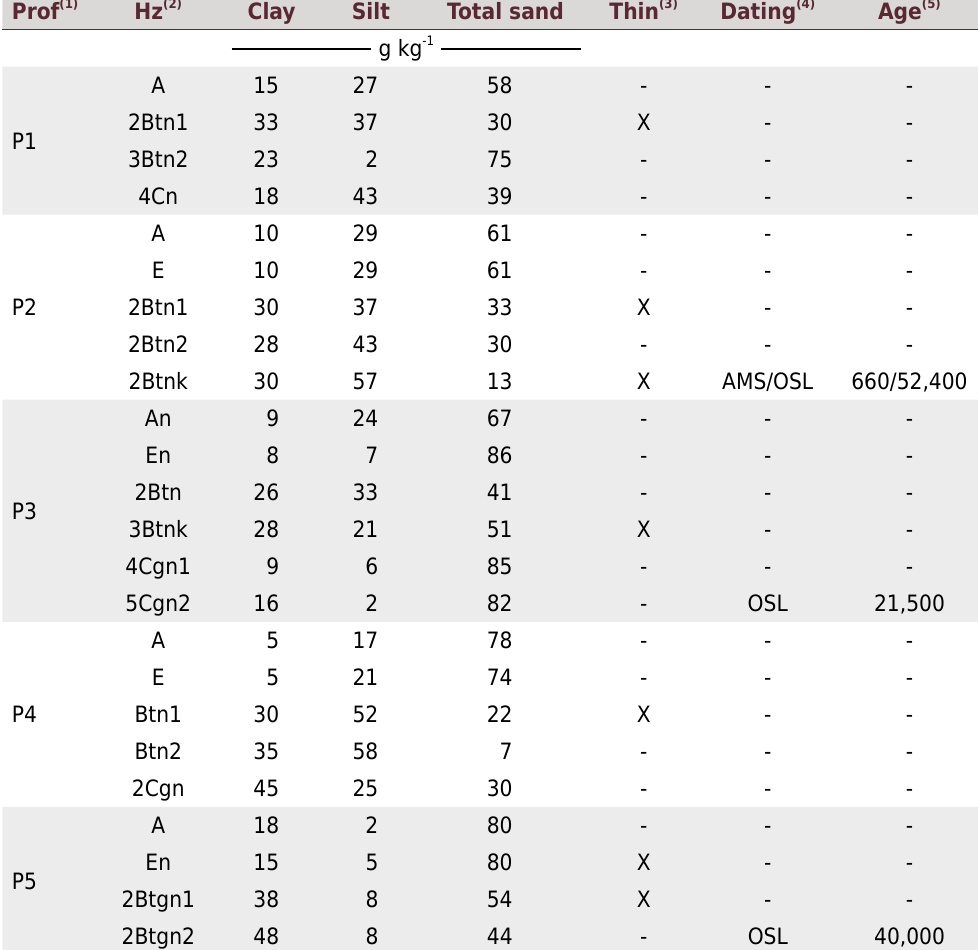
Table 2. Soil particle analysis, horizons sampled for making thin sections, dating, and determining ages Prof